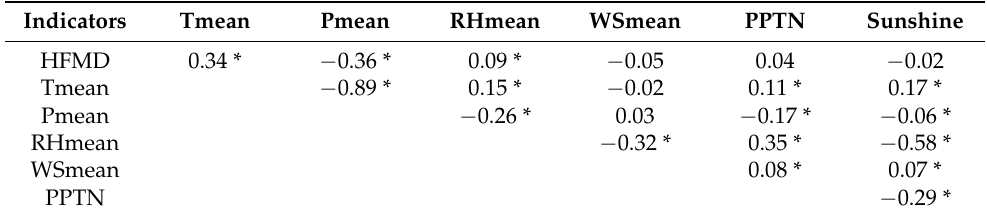
Table 2. Analysis of correlation between daily incidence of HFMD and meteorological variables.